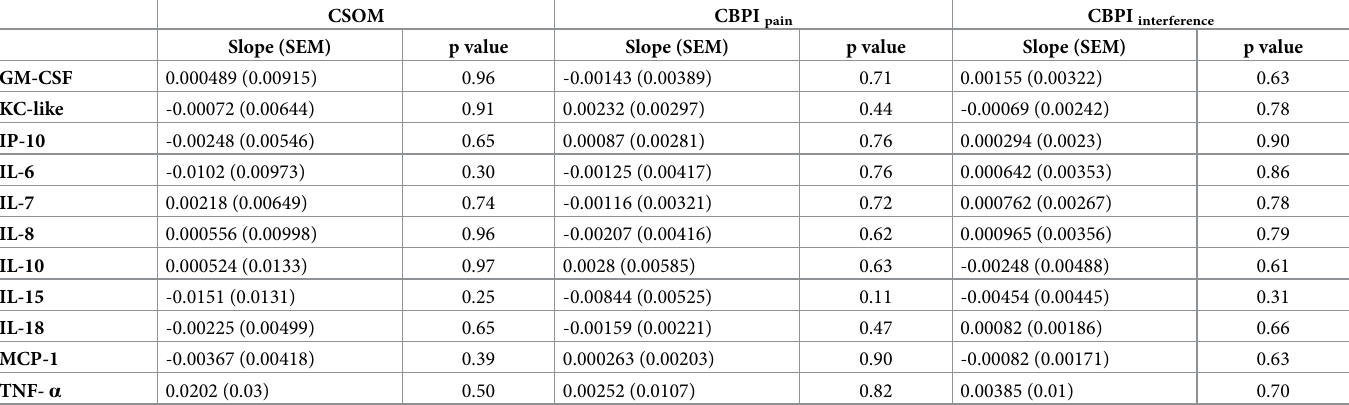
Table 7. Results of the statistical analysis evaluating the association between cytokines concentrations and a) Client Specific Outcome Measures scores b) Canine Brief Pain Inventory (section pain) scores c) Canine Brief Pain Inventory (section interference, locomotion)